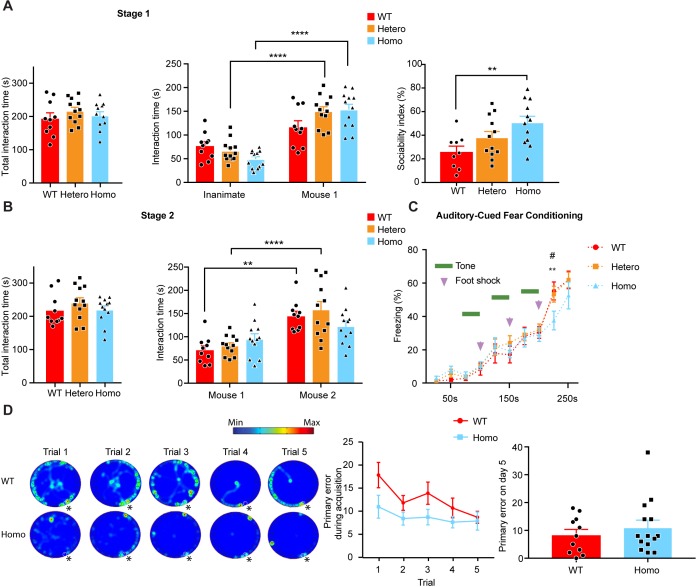
Sociability, fear acquisition, and primary error of Barnes maze in KIF5B conditional knockout mice.(A) Quantification of animal behavior in stage 1 of social interaction test. The left panel is the quantification of the total interaction time of mice with either object in stage 1 of the three-chamber social interaction test. n = 10 for WT. n = 11 for Hetero and Homo. Data are presented in mean + SEM, One-way ANOVA. The middle panel is the quantification of interaction time of mice with either the inanimate object or the social object (mouse 1) during stage 1 of three-chamber social interaction test. ****p<0.0001. Two-way ANOVA. The right panel shows the quantification of sociability index, which is the ratio of the difference between the interaction time of the social object and the inanimate object to the total interaction time of stage 1. n = 10 for WT. n = 11 for Hetero and Homo. Data are presented in mean + SEM. **p<0.01. One-way ANOVA with post hoc Tukey's HSD. (B) Quantification of animal behavior in stage 2 of social interaction test. The left panel is the quantification of the total interaction time of mice with either object in stage 2 of the three-chamber social interaction test. n = 10 for WT. n = 11 for Hetero and Homo. Data are presented in mean + SEM, Kruskal-Wallis test. The right panel is the quantification of interaction time of mice with either the novel social object (mouse 2) or the familiar social object (mouse 1) during stage 2 of three-chamber social interaction test. n = 10 for WT. n = 11 for Hetero and Homo. Data are presented in mean + SEM. **p<0.01. ****p<0.0001, Two-way ANOVA with post hoc Tukey's HSD. (C) Quantification of freezing time during acquisition stage of fear conditioning. The percentage of freezing of every 25 s interval are quantified and plotted along the time of fear conditioning. The appearance of conditioned stimulus (tone) and unconditioned stimulus (foot shock) is indicated. n = 12 for WT. n = 11 for Hetero. n = 11 for Homo. Data are presented in mean + SEM, Two-way ANOVA with post hoc Tukey's HSD. #p<0.05, comparison between WT and Hetero; **p<0.01, comparison between WT and Homo. (D) Left panel showing heat map showing the percentage of time the representative mouse of each genotype spent on the maze during acquisition phase. Black circles indicate non-target holes and white circles accompanied with asterisks indicate the target escape holes. WT mouse explored more non-target holes with higher number of primary error in the initial few trials, while Homo mouse stayed in the non-target hole with lower number of primary error during the acquisition phase. Middle panel showing quantification of primary error during acquisition phase and quantification of primary error on day five during recall in the right panel. (n = 11 for WT, n = 13 for Homo) Data are presented in mean + SEM. *p<0.05, Two-way ANOVA with post hoc Tukey's multiple comparison test.
Figure 8—figure supplement 2—source data 1.Plotted values for Figure 8—figure supplement 2.